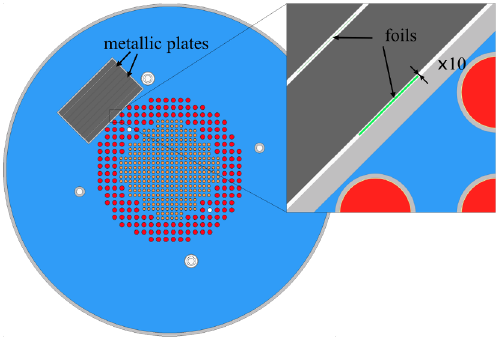
Figure 5. Serpent2 CROCUS geometry with the PETALE ex- perimental